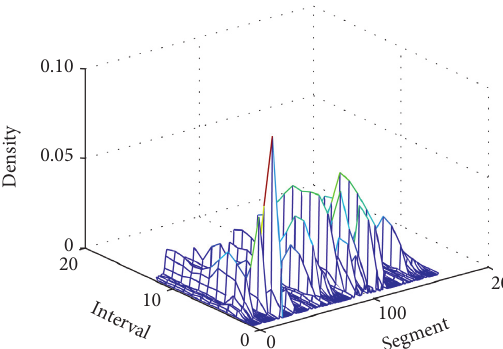
Figure 7: The averaged density without control. Figure 10: The averaged density with control.